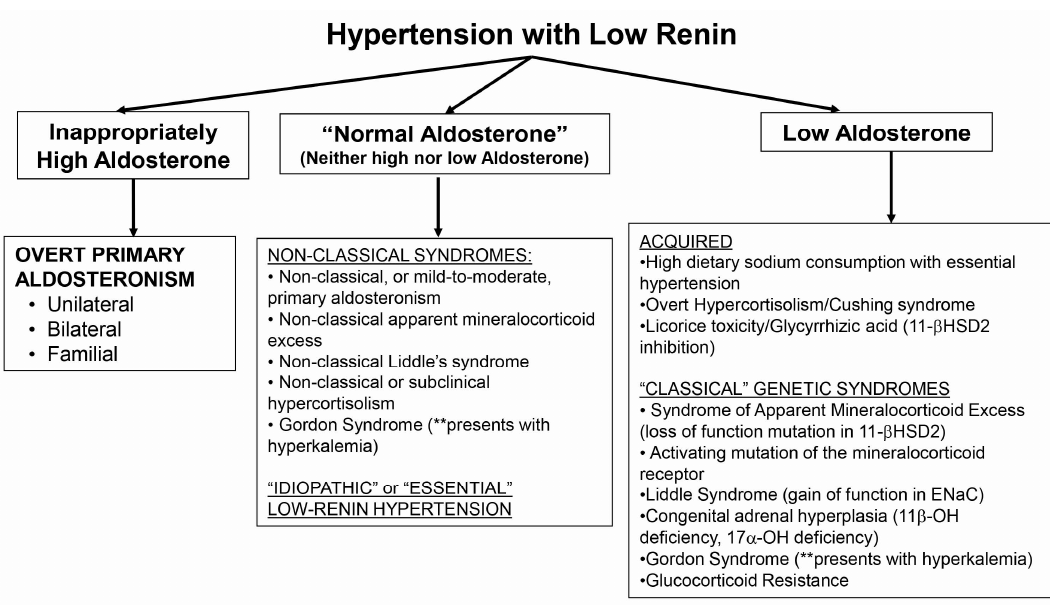
Figure 1. A proposed approach to the patient with low-renin hypertension. ENaC = epithelial sodium channel; 11- β HSD2 = 11- β hydroxysteroid dehydrogenase type 2; 11 β -OH = 11- β hydroxylase; 17 α -OH = 17- α hydroxylase.